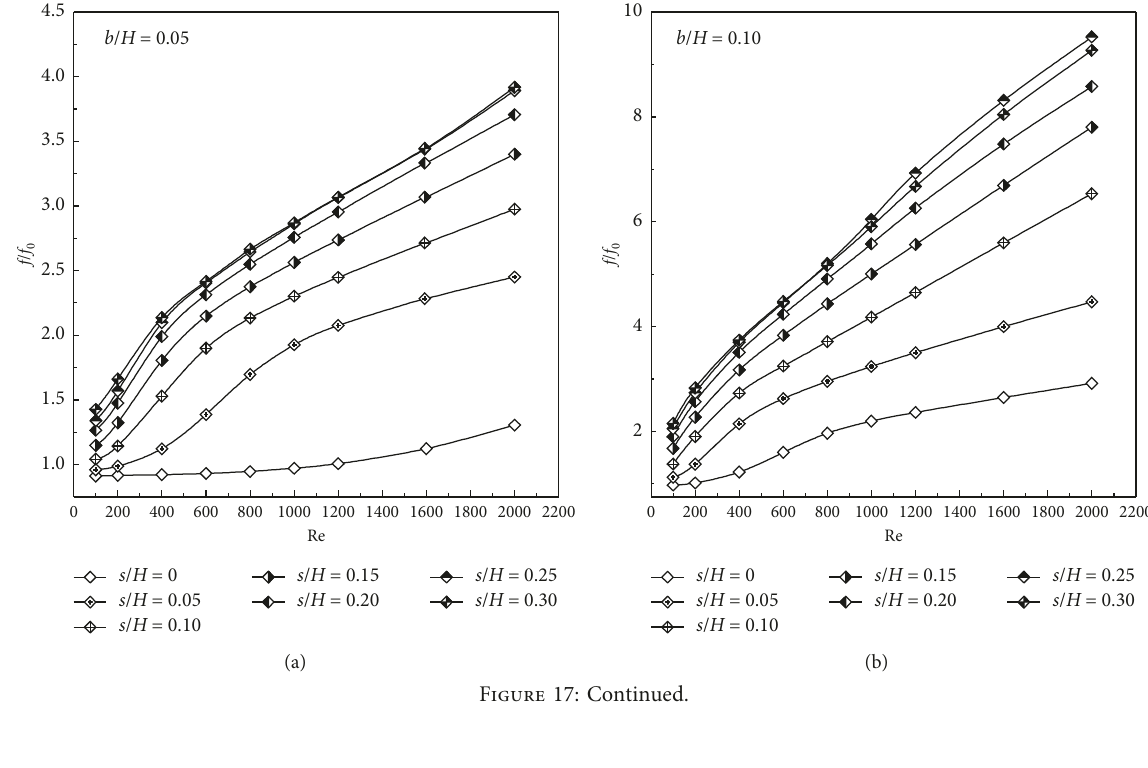
0.25, and (f) b / H (cid:31)